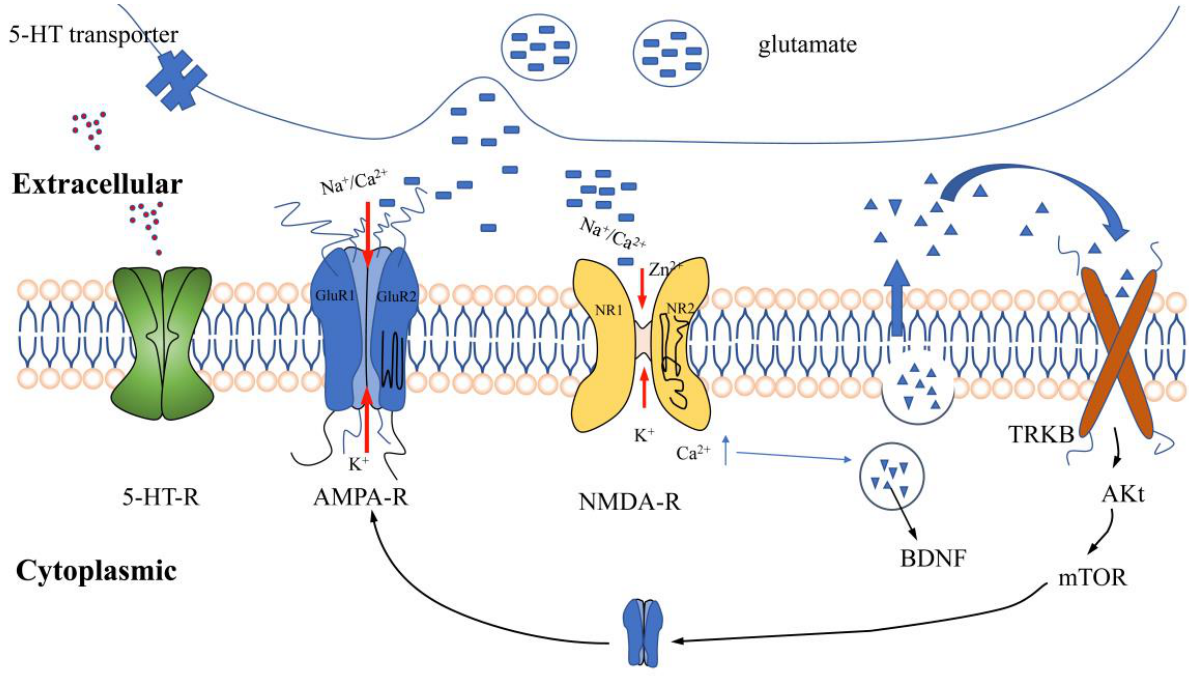
Figure 5. Receptors for antidepressant